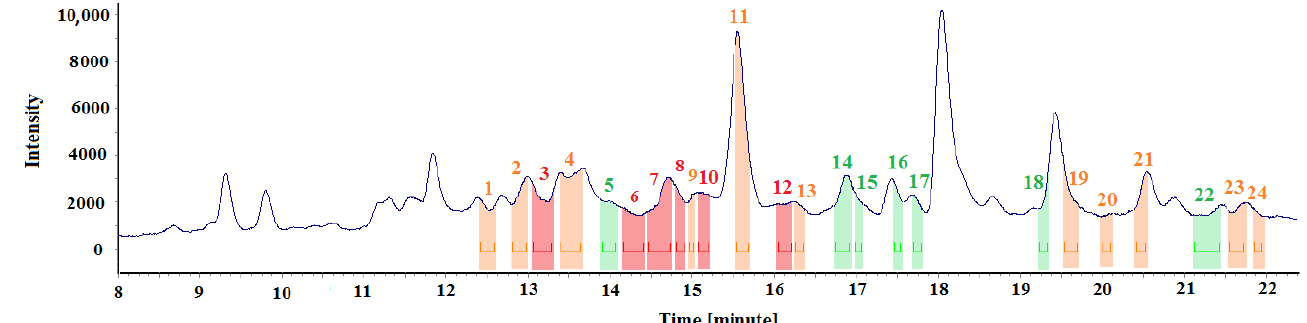
Figure 8. Chromatographic spectrum with the applied odour signals obtained for the samples of floor staves exposed to elevated desorption temperature. Table 4. Identification of the signals obtained for the samples of floor staves exposed to elevated desorption temperature.